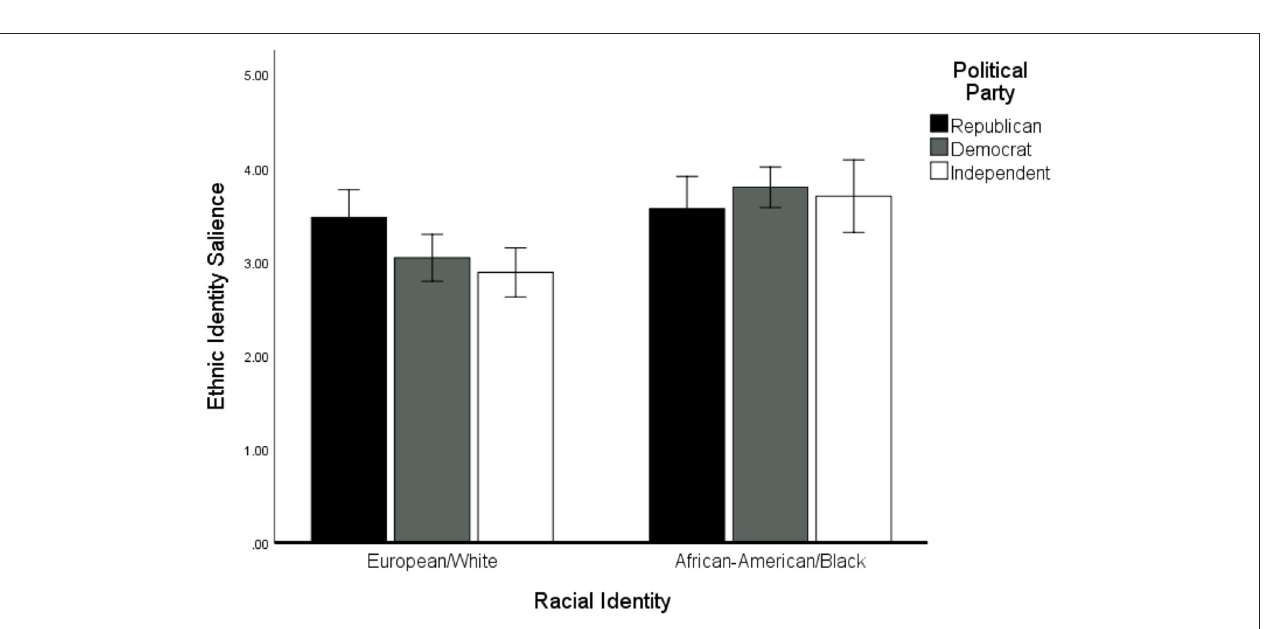
FIGURE 3 | Racial identity salience among Black/African-American and White/European-American participants of different political affiliations (Republican, Democrat, Independent). Note. Error bars represent 95% CIs around the mean for each